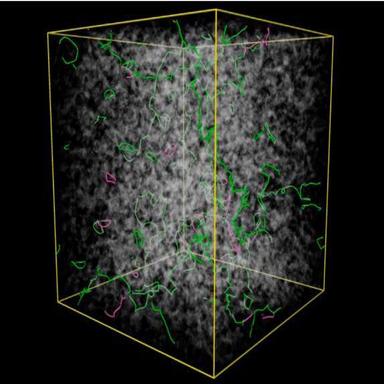
A view of the microstructure of bcc iron exposed to the irradiation dose of 2.5 dpa. Most of self-interstitial atoms have coalesced into dislocation loops and dislocation network, while vacancies remain dispersed in the bulk of the material. The high vacancy content predicted by the simulations agrees with positron annihilation spectroscopy (PAS) experiments as well as with the variation of hydrogen isotope retention as a function of dose.